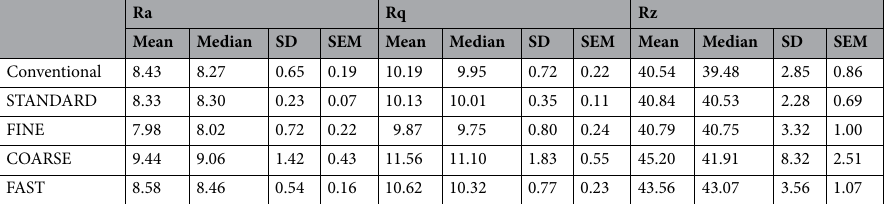
Table 2. Surface roughness analysis for 5 Pe-Lite surface samples. Results presented are averages (mean) of twelve measurements (Unit—µm). SD Standard Deviation, SEM Standard Error of